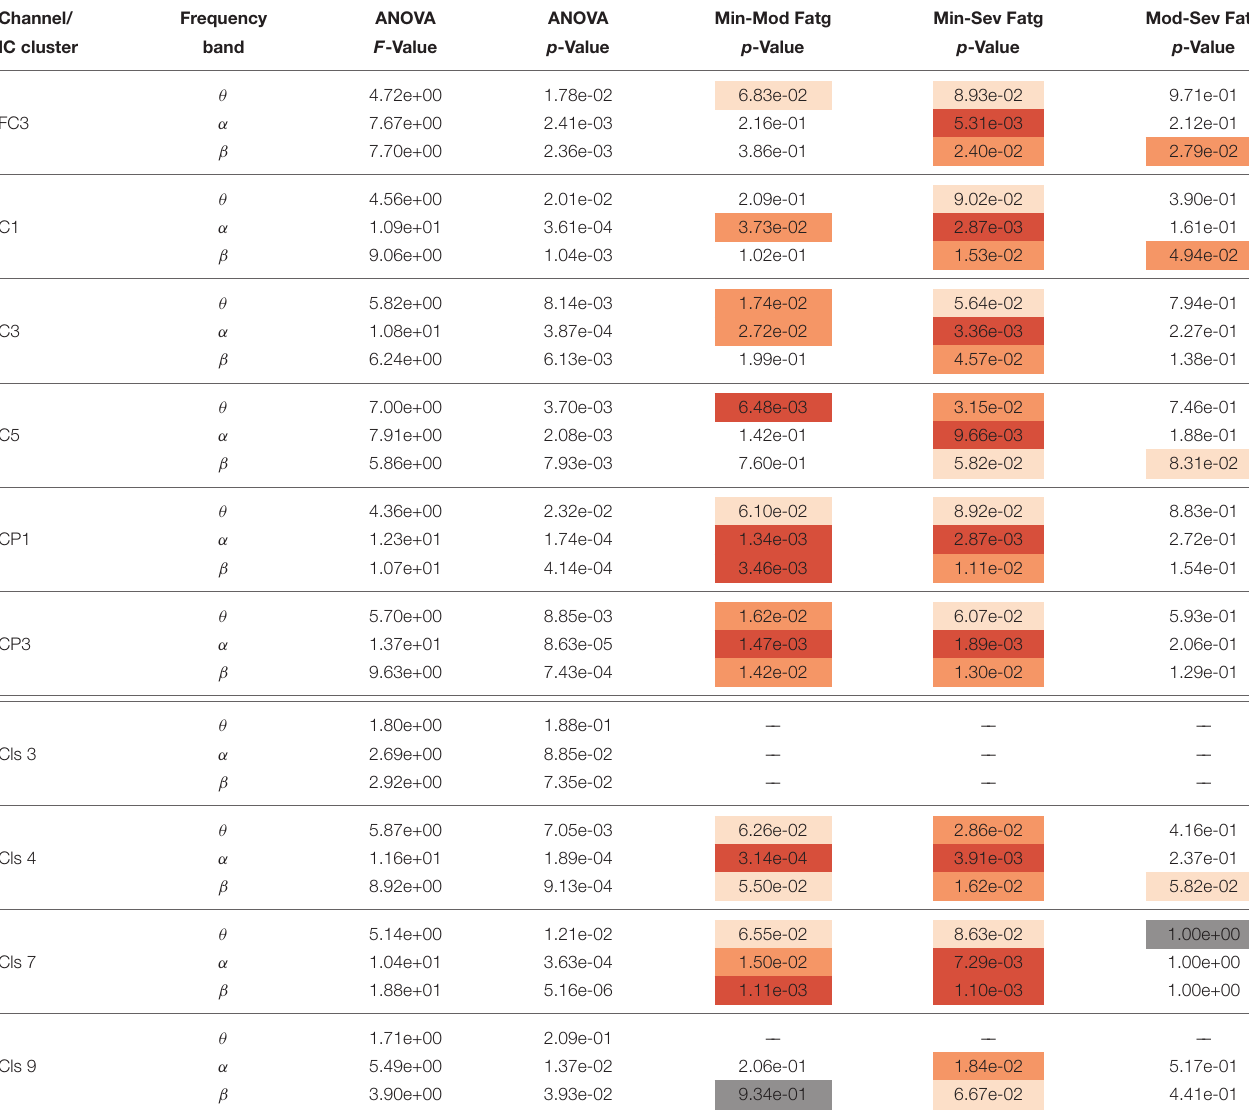
The F- and p-values of ANOVA and the p-values from the post-hoc analysis (if p < 0.05 from ANOVA) are listed. The light, medium, and dark shades of red denote that the PSD increases with fatigue with a statistical significance of p < 0.1 , p < 0.05 , and p < 0.01 , respectively. The counter cases, where the PSD decreases as the fatigue increases without a statistical significance, are shaded in